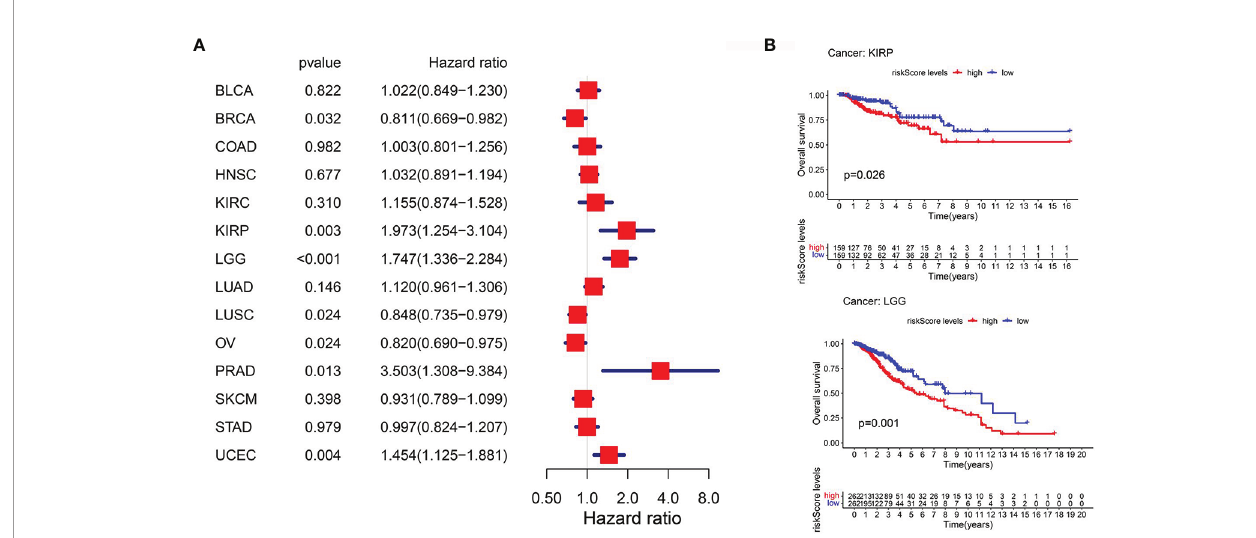
FIGURE 7 | Pan-cancer analysis using TCGA database. (A) Univariate Cox regression analysis for 14 kinds of tumors. (B) Km survival curve analysis between the high-PERs and low-PERs groups, with a P value <0.05.